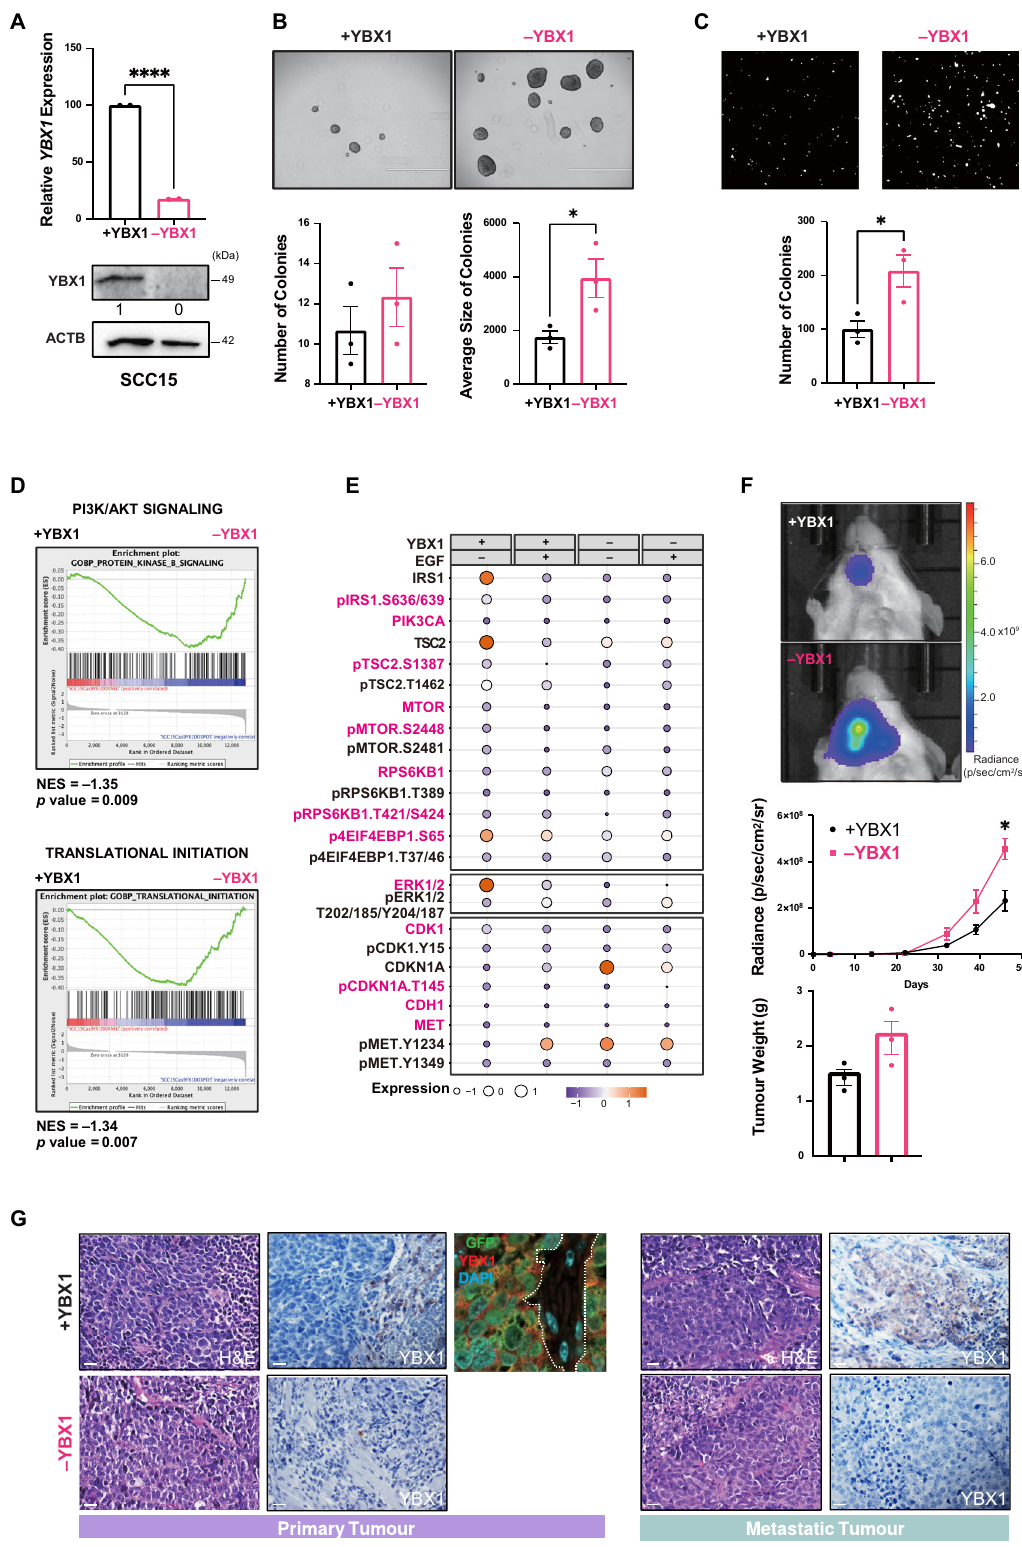
based on the expression of S and G2/M phase markers, and cells expressing neither marker were identi fi ed in theG1phase.